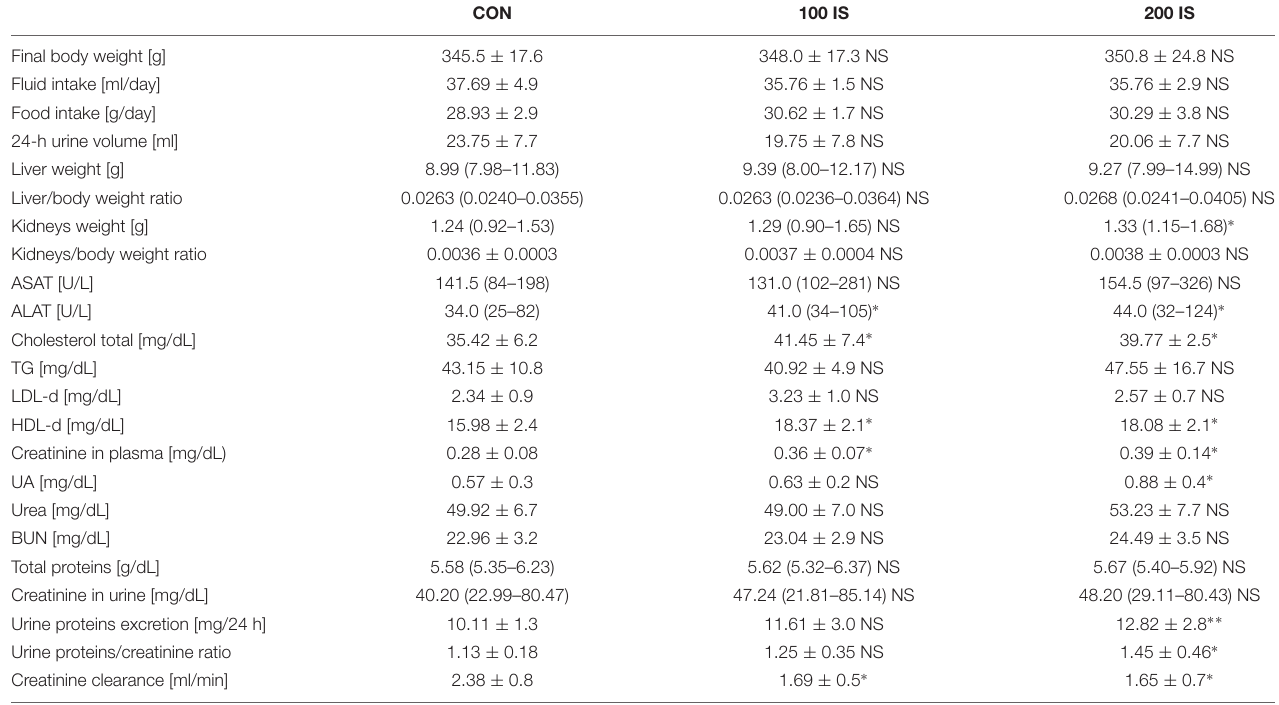
TABLE 2 | General characteristics of rats. CON 100 IS 200